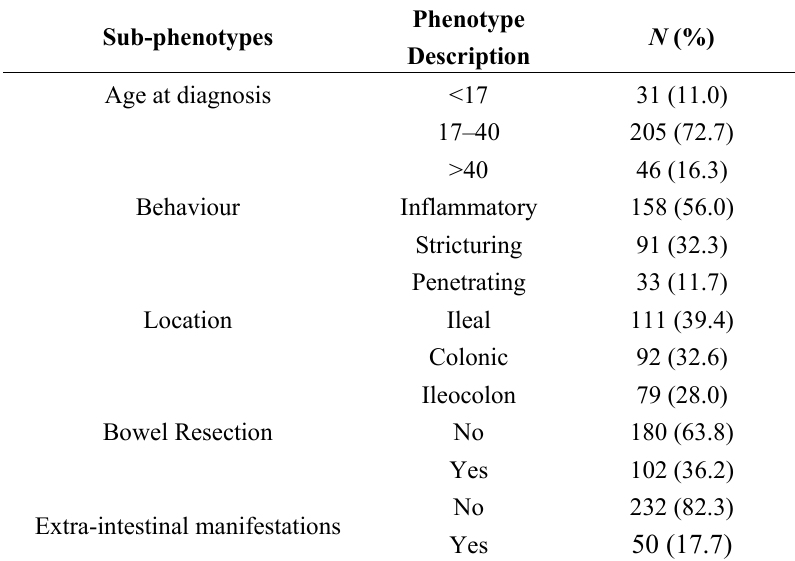
Table 1. Summary of sample sizes and clinical data for those with Crohn’s disease